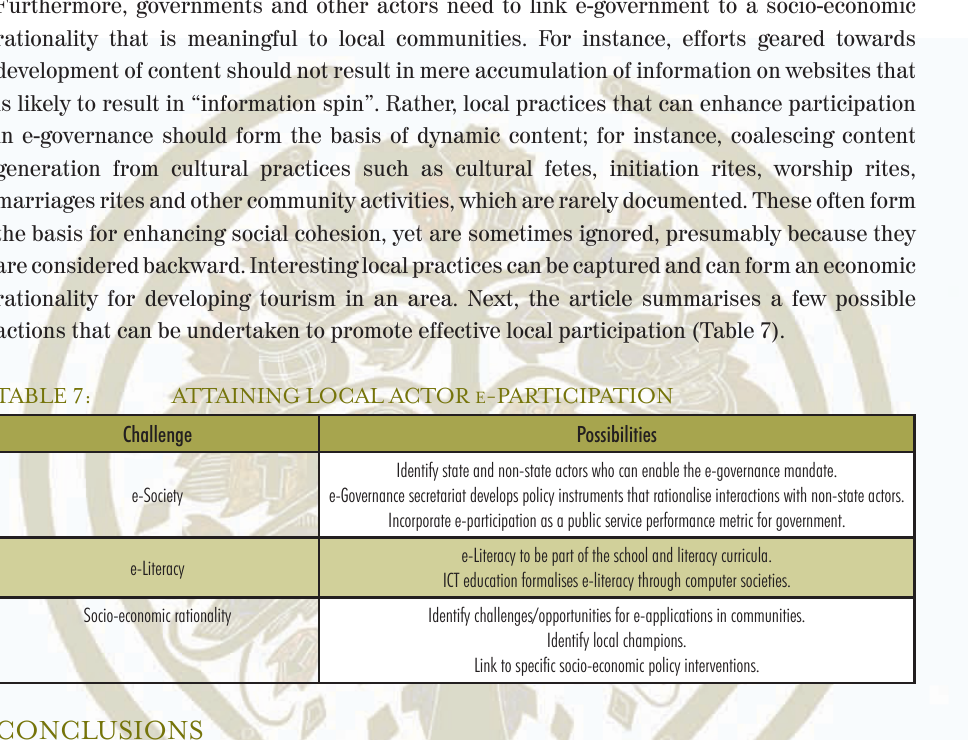
TABLE 7: ATTAINING LOCAL ACTOR E -PARTICIPATION Challenge Possibilities Identify state and non-state actors who can enable the e-governance mandate. e-Society e-Governance secretariat develops policy instruments that rationalise interactions with non-state actors. Incorporate e-participation as a public service performance metric for government. e-Literacy Socio-economic rationality Identify challenges/opportunities for e-applications in communities. Identify local champions. Link to specific socio-economic policy